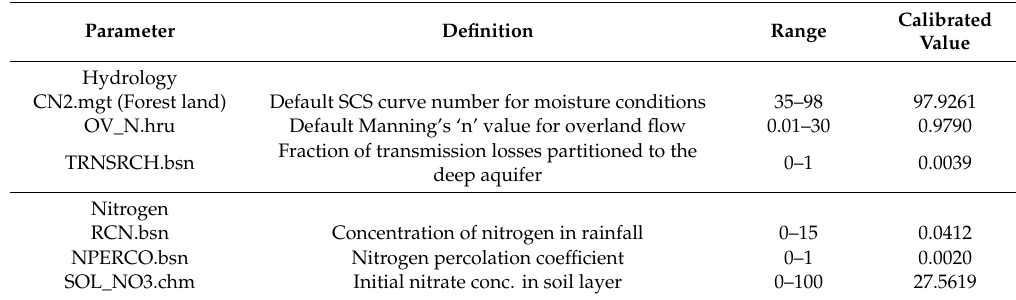
Table 2. Key parameter values and sensitivities for streamflow and total nitrogen (TN) load simulation in the